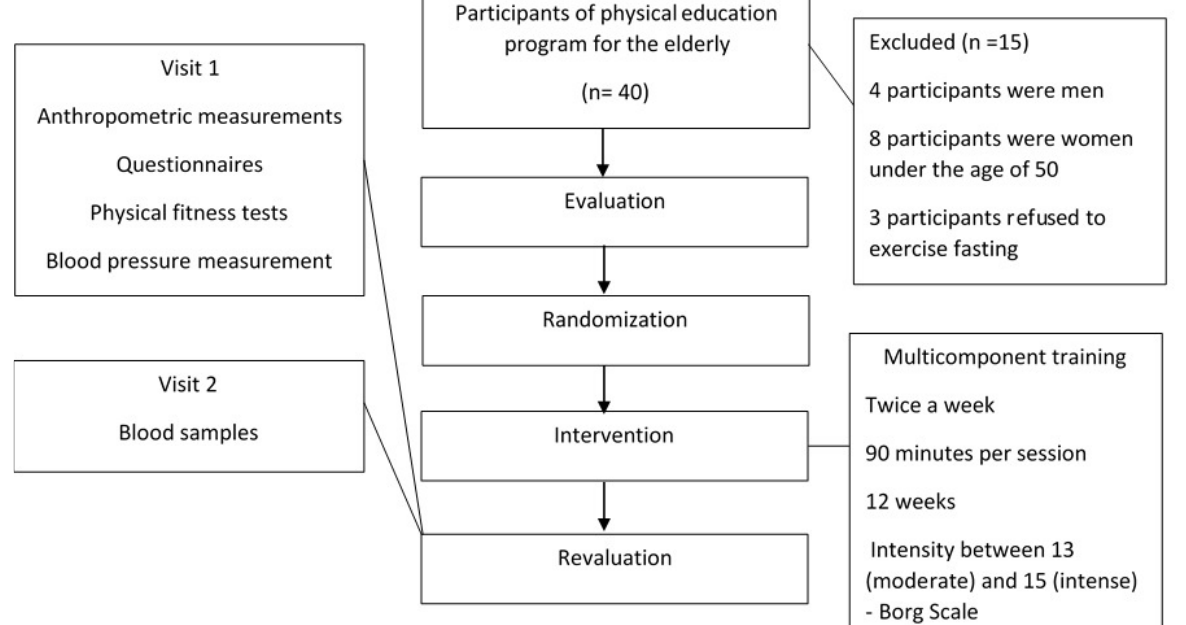
Figure 1. Flow chart and sample